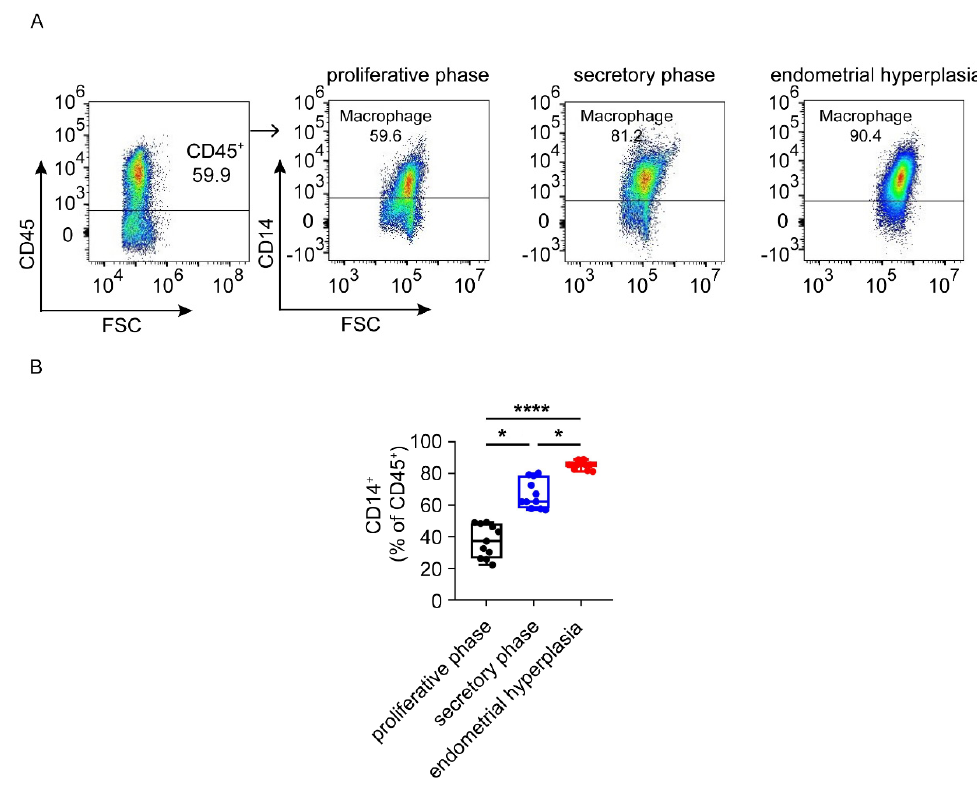
Figure 5. The proportion of macrophages in proliferative phase, secretory phase and endometrial hyperplasia endometrium of AUB patients. ( A ) CD45 + gate, followed by CD14 + gate, was used to distinguish monocytes. ( B ) Graph shows the proportions of general monocytes in three groups. Data are presented as the median and the interquartile range. Statistical significance (Kruskal–Wallis test with Dunn’s multiple-comparison test): * p < 0.05, **** p < 0.0001.